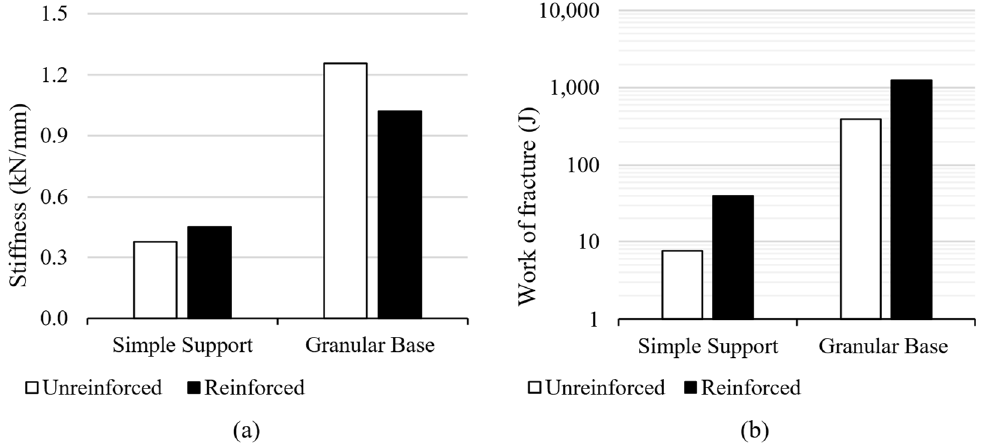
Figure 10. Comparison between the results obtained from ( a ) stiffness and ( b ) work of fracture in a log scale from the testing samples.